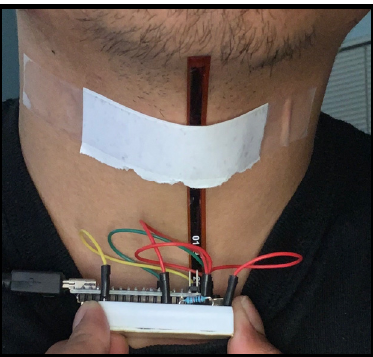
Figure 2. ( a ) Low, ( b ) center, and ( c ) high placement of the short flex sensor along the center line of the neck.